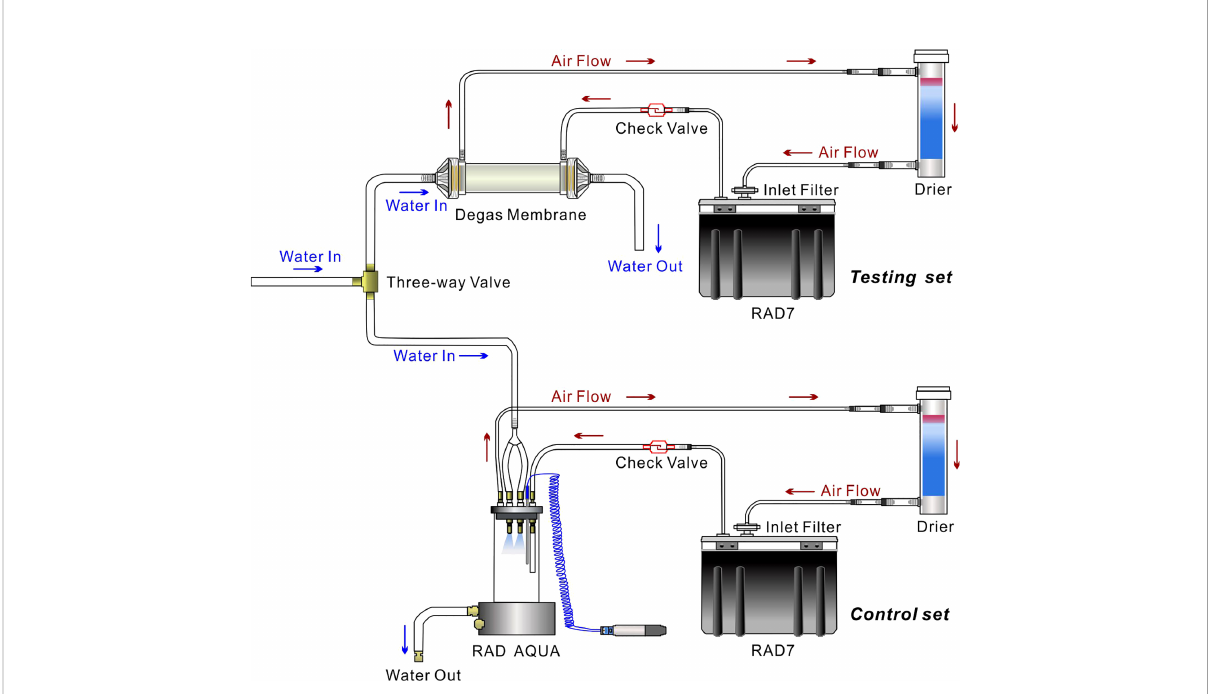
FIGURE 4 Schematic layout of the experimental conditions for examining gas-water equilibration times by two different approaches. The fi gure was hand- drawing utilizing CorelDRAW